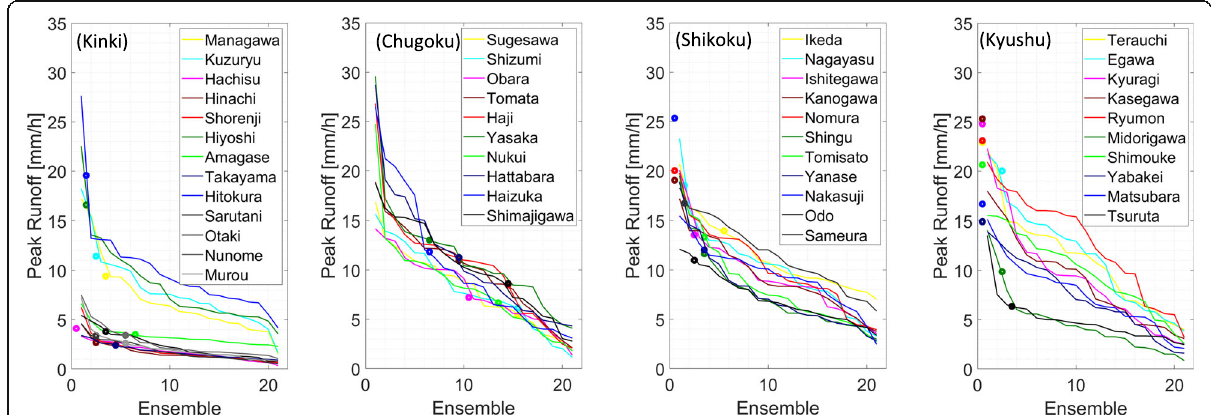
Fig. 4 Peak runoff by ensemble forecasting (lines) and the simulation (dots) at all the dam reservoirs for F18. The x -axis shows the 21 ensemble members in descending order of forecasted peak runoff shown on the y -axis. Note that the flood peaks were evaluated after 16:00 6 July 2018 to exclude the effects of first flood peaks, which occurred at some dam reservoirs nearly at the same time as the MEPS initial time for